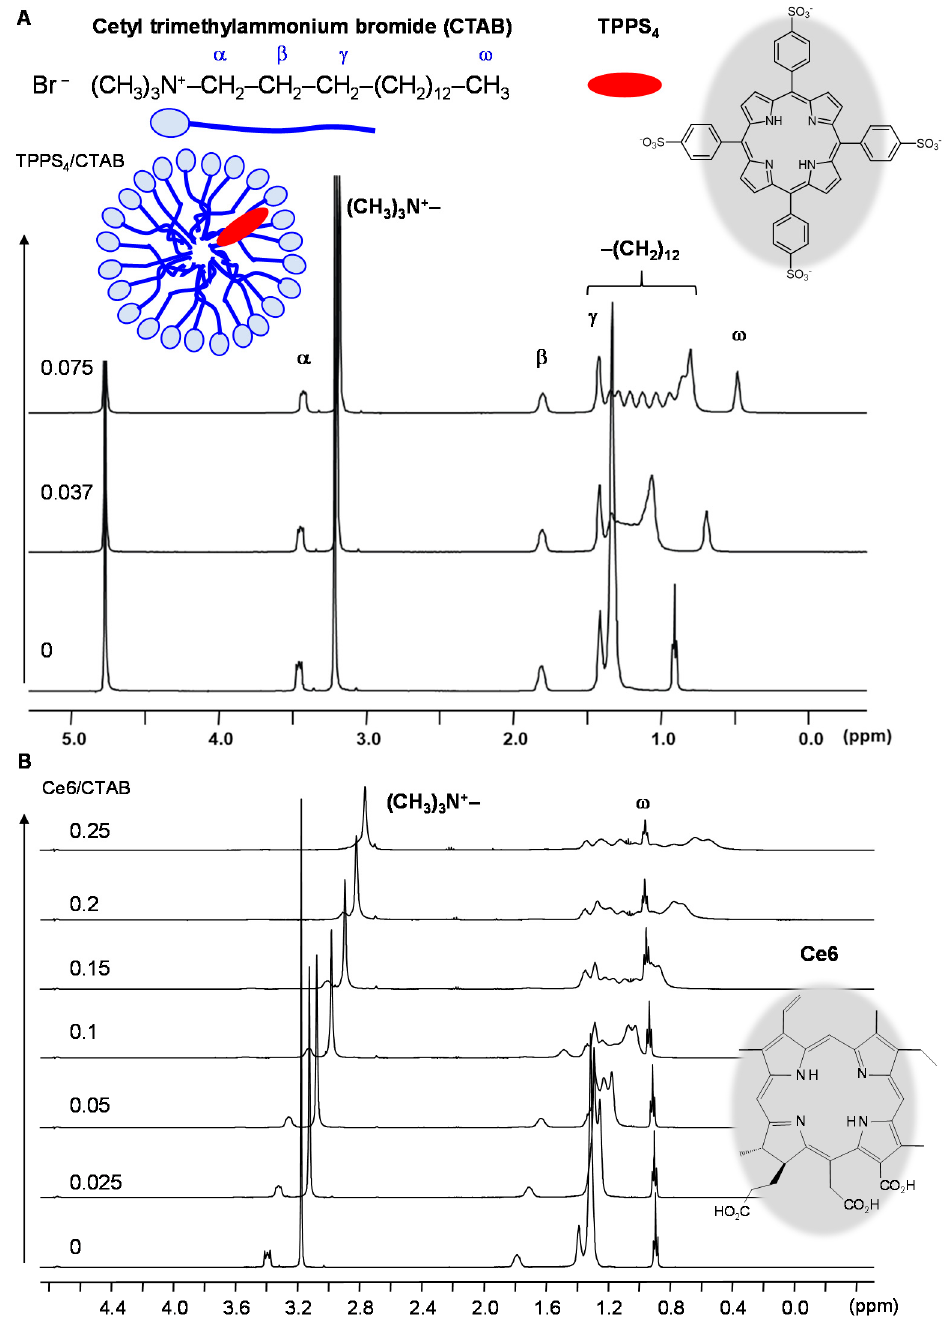
Figure 10. 1 H NMR spectra of CTAB micelles ( A ) in the presence of TPPS 4 and ( B ) in the presence of chlorin e6 (Ce6) at increasing molar ratios TPPS 4 /Ce6 : CTAB in aqueous buffer solutions (pH = 7.2, CTAB constant concentration 40 mM) (unpublished data).